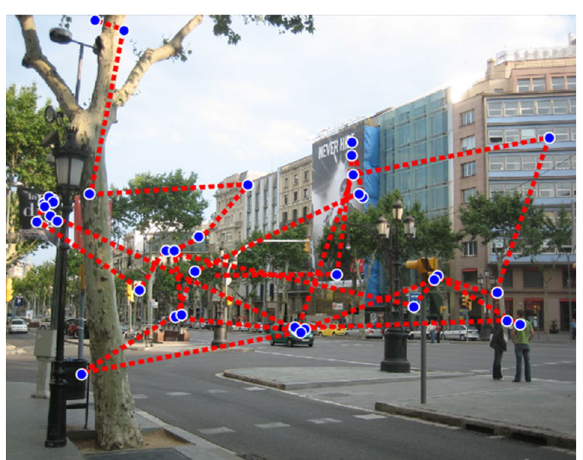
Figure 6. Example of a representative gaze-pattern from one subject. Blue points represent fixations, red dotted lines represent saccades. Image is from the LabelMe database 45 , made publicly available to the research community without